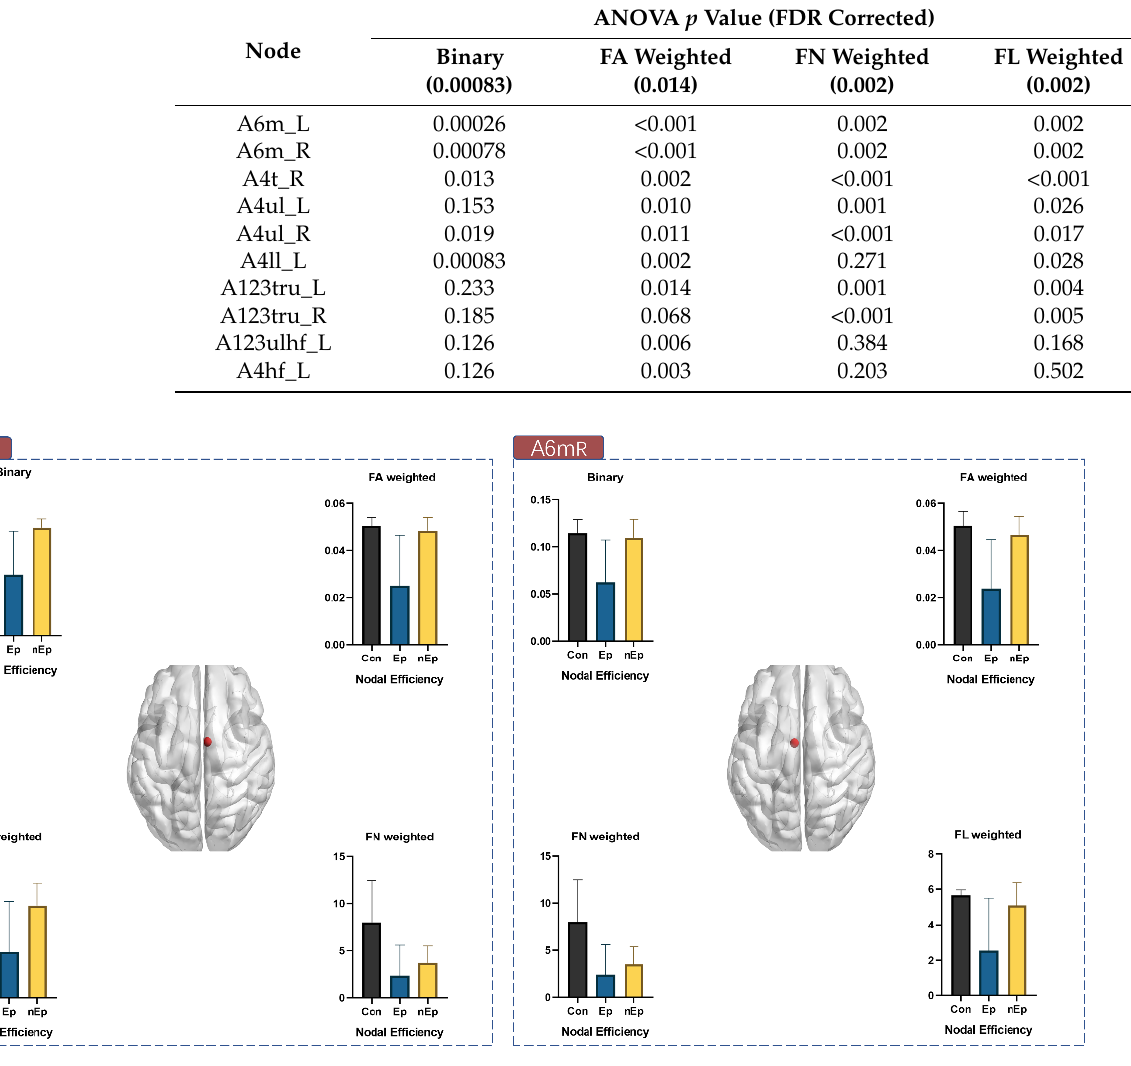
Table 4. Ten nodes that exhibited nodal efficiency difference.